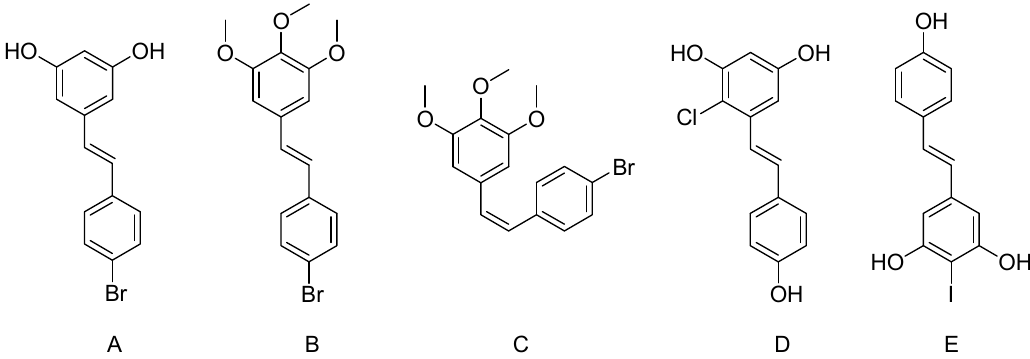
Figure 4. Chemical structure of selected halogenated resveratrol derivatives. ( A ) 4 ′‐ Bromoresveratrol; ( B ) 3,4,5 ‐ Trimethoxy ‐ 4 ′‐ bromo ‐ trans ‐ stilbene (BTS); ( C ) 3,4,5 ‐ Trimethoxy ‐ 4 ′‐ bromo ‐ cis ‐ stilbene (BCS); ( D ) 2 ‐ Chlororesveratrol; ( E ) 4 ‐ Iodoresveratrol.